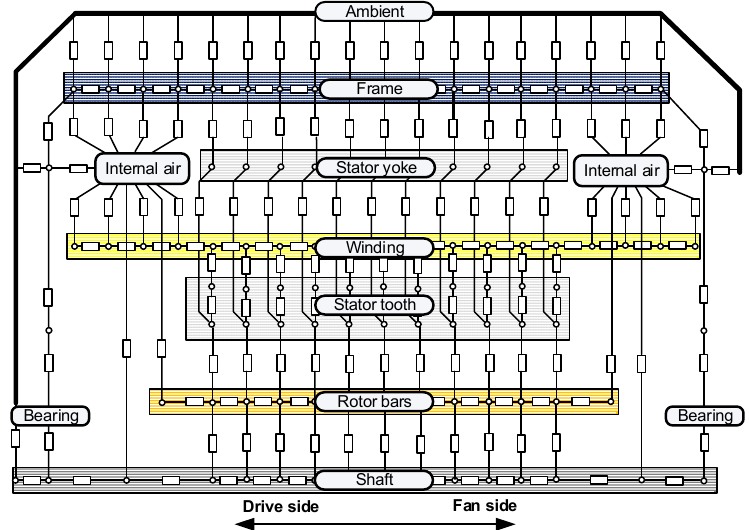
Figure 18. “I-type” based discretized LPTM for a 15 kW TEFC IM [37].